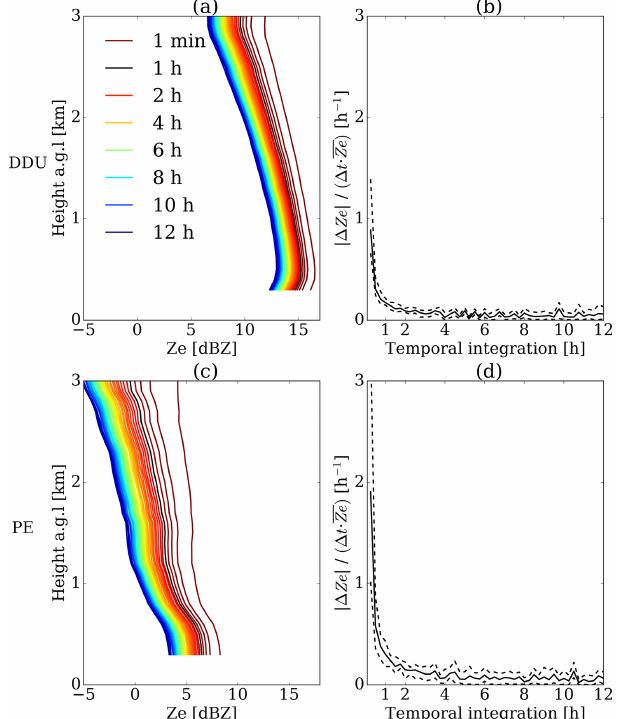
Figure 2. Average VPRs at different temporal integrations are dis- played in panels (a) and (c) , for DDU and PE, respectively. Colored lines represent different temporal integration steps, corresponding to 1min and from 15min to 12h separated by 15min intervals (leg- end displays only a few selected time steps and 1h VPR is rep- resented in black). The temporal variability between time steps is shown in panels (b) and (d) , for DDU and PE. Bold lines corre- spond to the mean reduction of Ze as a function of the temporal integration step, weighted by time interval and the mean Ze at the given timescale. Dashed lines are the maximum and minimum re- ductions of Ze within the whole average